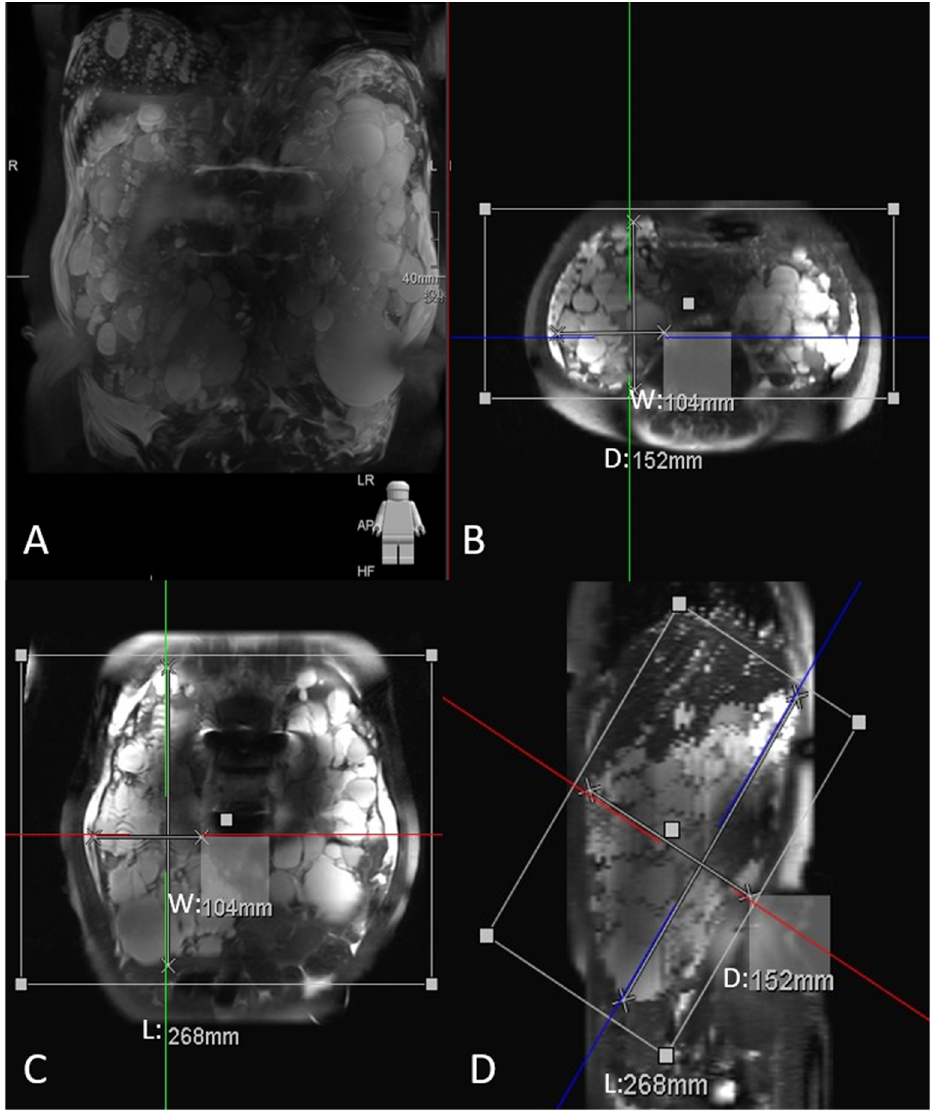
Figure 2. Multiplanar reformation can estimate total kidney volume with the maximal intensity projection ( A ). The maximal length (L), width (W), and depth (D) can be obtained from the oblique coronal plane ( C ), sagittal plane ( D ), and tilted axial plane ( B ), sequentially. Nonenhanced MRI and CT images at the L3 level were analyzed to determine TAM, VAT, and SAT areas processed on a compatible computer by using open-source software (ImageJ version 1.51; National Institutes of Health, Bethesda, MD, USA). Contours were obtained using a manual tracing method (Figure 3). A radiologist (C.-H.W.) with 10 years of experience in abdominal imaging processed the images based on the method described previously [20]. The TAM, VAT, and SAT indices were calculated as follows: TAM, VAT, and SAT area/(BH [m]) 2 . Sarcopenia was defined as a TAM index of <52.4 cm 2 /m 2 in men and <38.5 cm 2 /m 2 in women, according to Prado’s protocol [21].